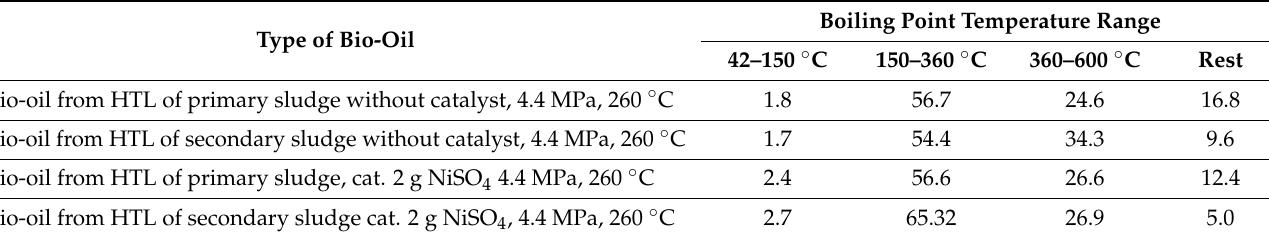
Table 5. Boiling point distribution of biocrude substances. Type of